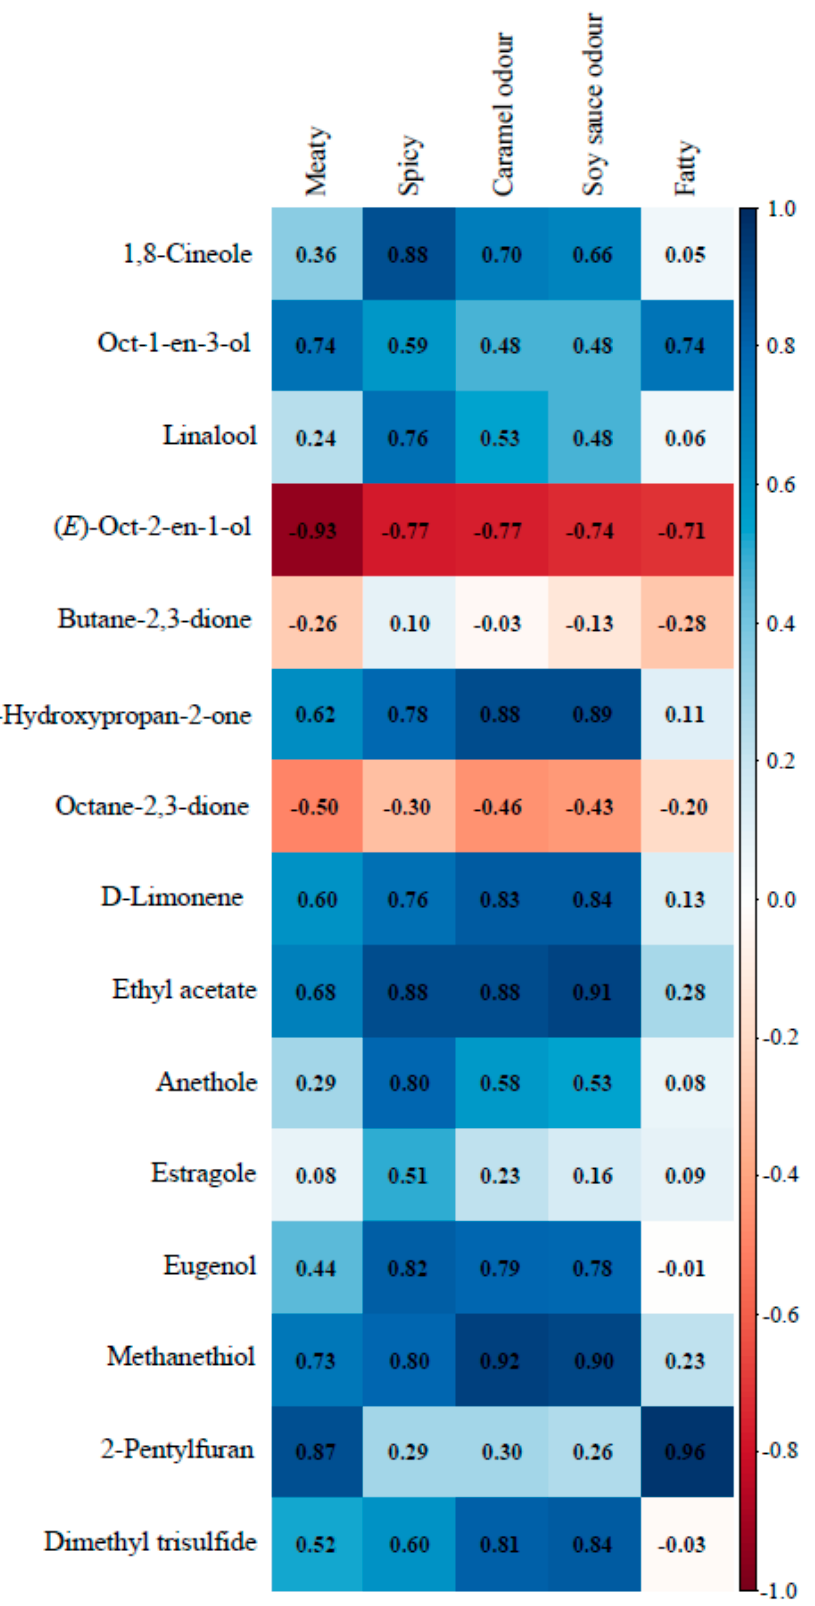
Figure 5. ( a ) PLSR loading for the odour attributes (Y variables) and the odour-active compounds of the fresh and stewed pork (X variables). ( b ) Heat map illustrating the Pearson correlation between descriptor intensities and proportion of OAVs of the odour- active compounds calculated by PLSR. The green circle dots represent 7 pork samples, the red circle dots represent 5 aroma attributes and the purple triangle dots represent 29 odour-active